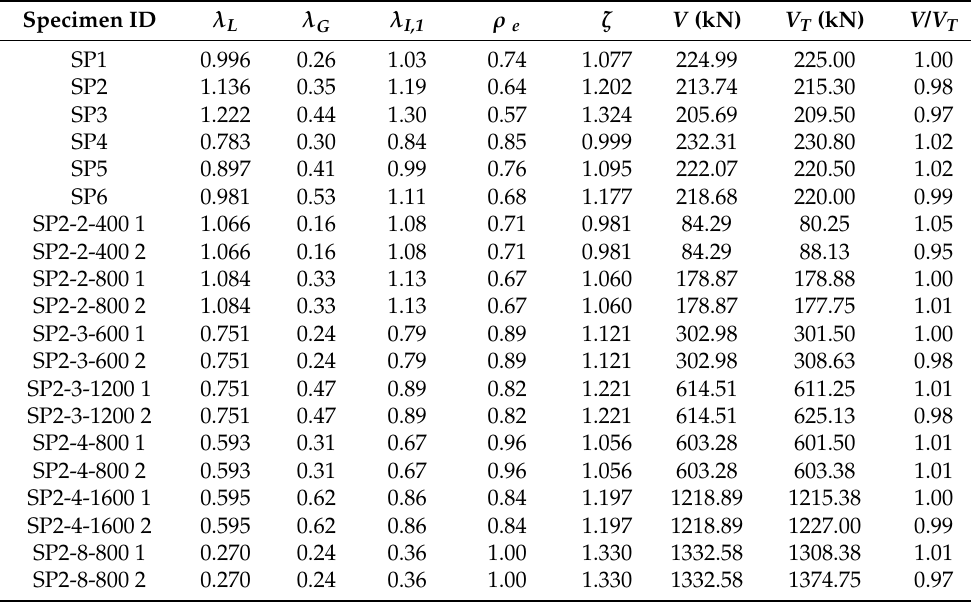
Table A13. Analysis results of test specimens reported by Peil [27].